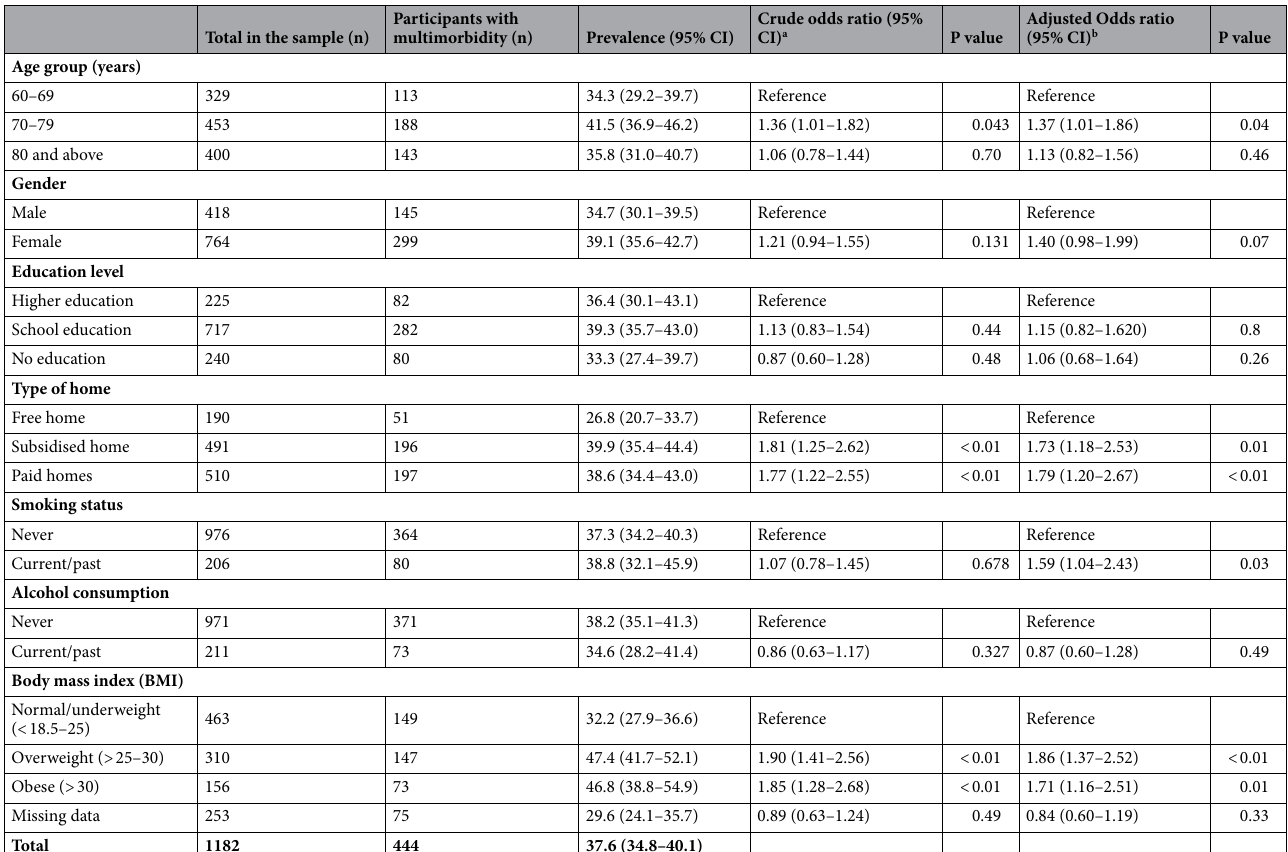
Table 1. Association of multimorbidity (≥ 2 conditions) with sociodemographic and other characteristics (multiple logistic regression analysis). a Based on simple logistic regression with multimorbidity as the outcome variable. b Based on multiple logistic regression with multimorbidity as the outcome variable and the predictors entered at the same time.